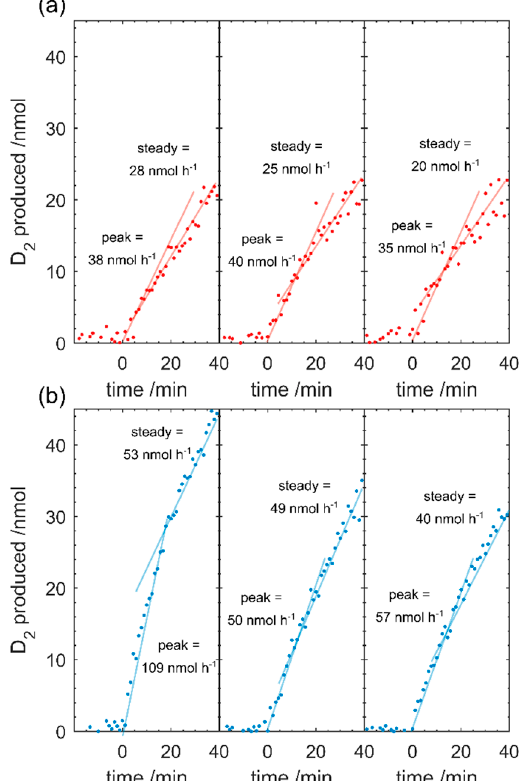
Figure 5. Photocatalytic production of D 2 ( m / z = 4) for ( a ) P25-Pt-np-1 wt% photocatalyst and ( b ) P25-Pt-nc-2 wt% photocatalyst. Each shows repeated experiments for the same photocatalytic disc (1.3 cm 2 ) loaded with ~1.5 mg photocatalyst, and reaction cell evacuated between experiments. Light Table 1. Photocatalytic D 2 peak and steady production rates for the photocatalysts studied with Pt mass and steady production rate per gram of Pt on the sample. All data are from at least 3 individual photocatalytic discs (~1.5 mg, 1.3 cm 2 ) with each disc repeated 3 times.